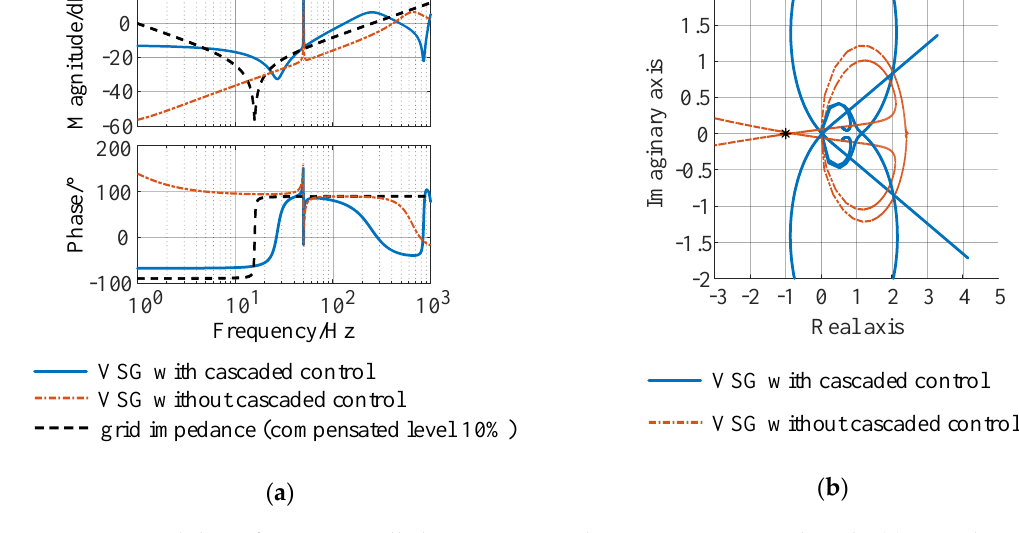
Figure 11. Stability of VSG controlled converters with series-compensated grid: ( a ) impedance characteristics; and ( b ) Nyquist plot.